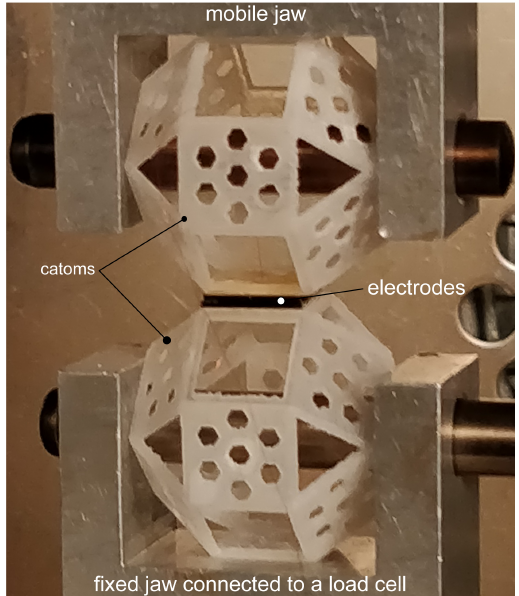
Figure 9. Experimental